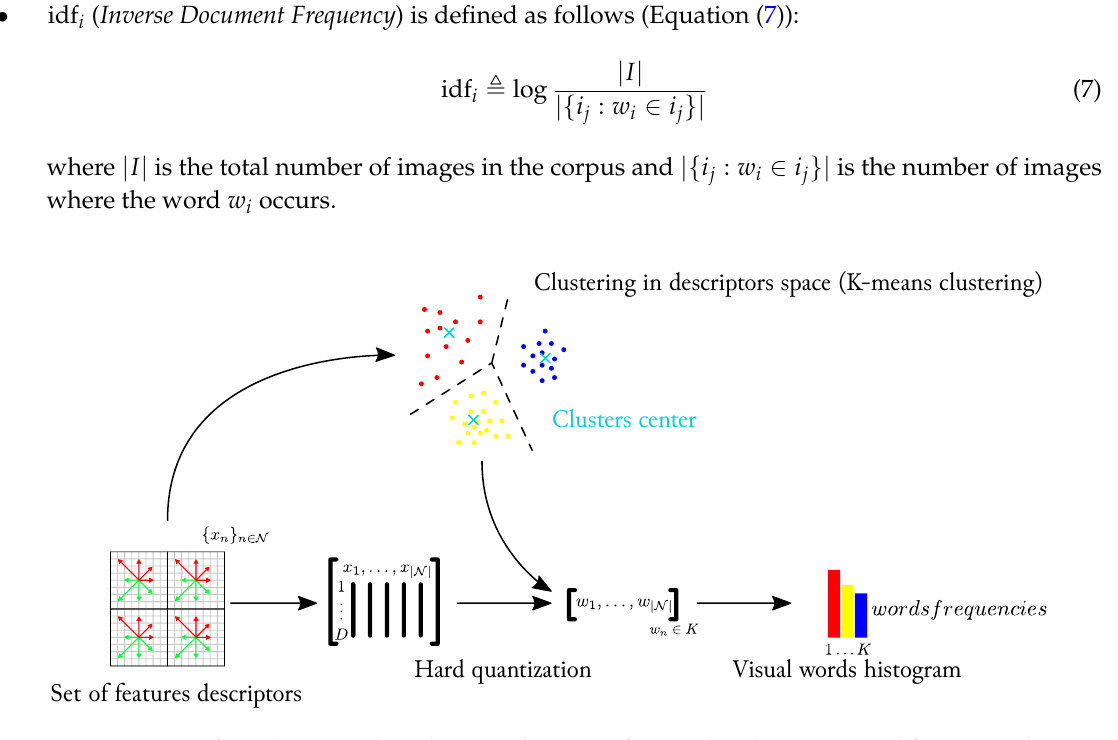
Figure 11. Bag-of-Words approach: a “learning dataset” is first used to cluster extracted features in the descriptor space. Features are then quantified according to nearest cluster. The resulting representation of the images are visual words